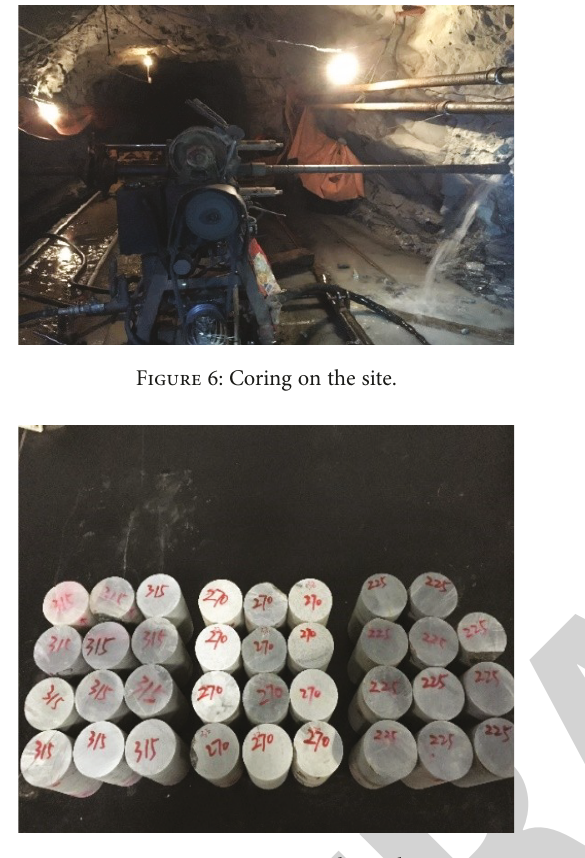
Figure 7: Some processed samples.